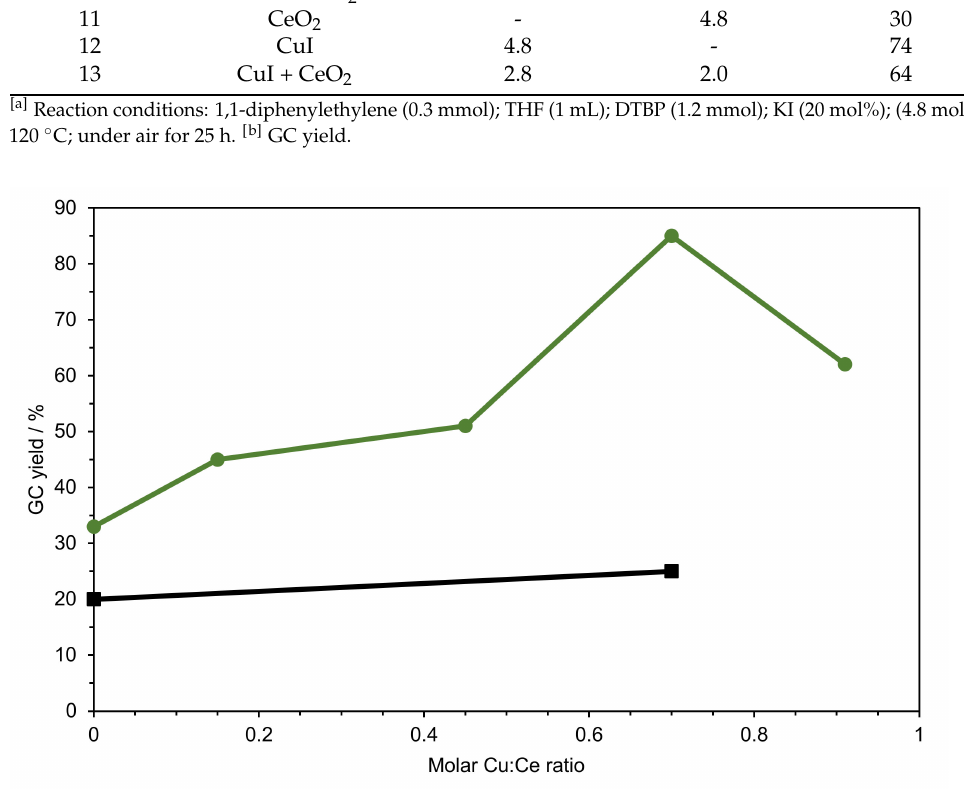
Figure 12. Yield of 2-(2,2-diphenylvinyl)-tetrahydrofuran vs. molar Ce:Cu ratio in CuO-CeO 2 - SiO 2 composites from solution combustion (solid circle) and CuO-CeO 2 mechanical mixtures (solid